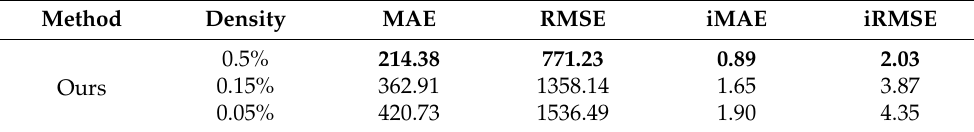
Table 3. Depth completion of the KITTI test dataset with varying sparse depth densities.